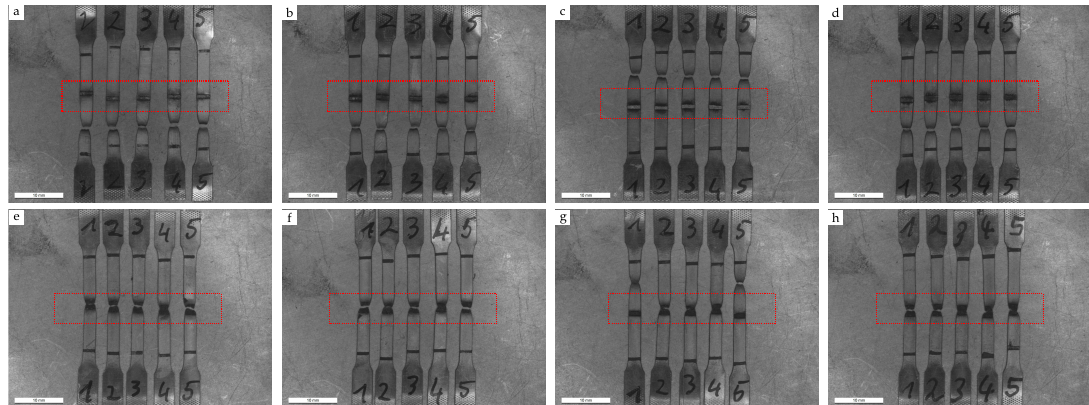
Figure 12. Photographic images of fractures in tensile specimens of ( a – d ) AISI430 and ( e – h ) AISI430Ti welded at different energy inputs (left to right: 18 J · mm − 1 –24 J · mm − 1 ). Weld seam area marked with red